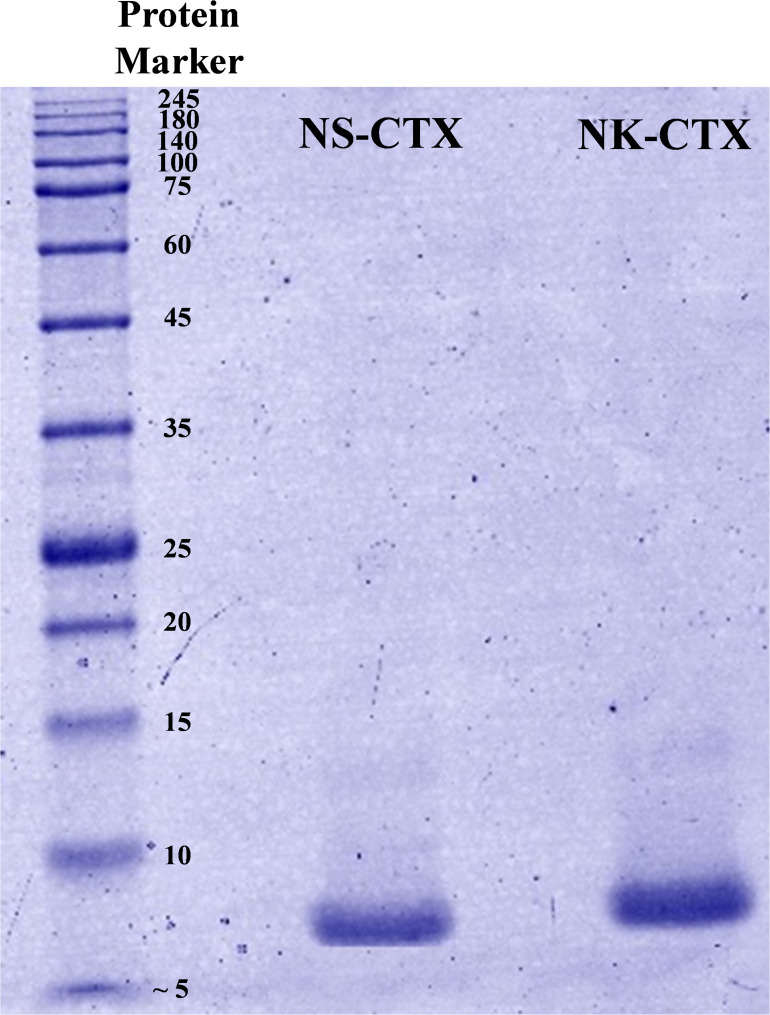
Sodium dodecyl sulfate-polyacrylamide gel electrophoresis of cytotoxins purified from Naja sumatrana (NS-CTX) and Naja kaouthia (NK-CTX) venoms under reducing condition.